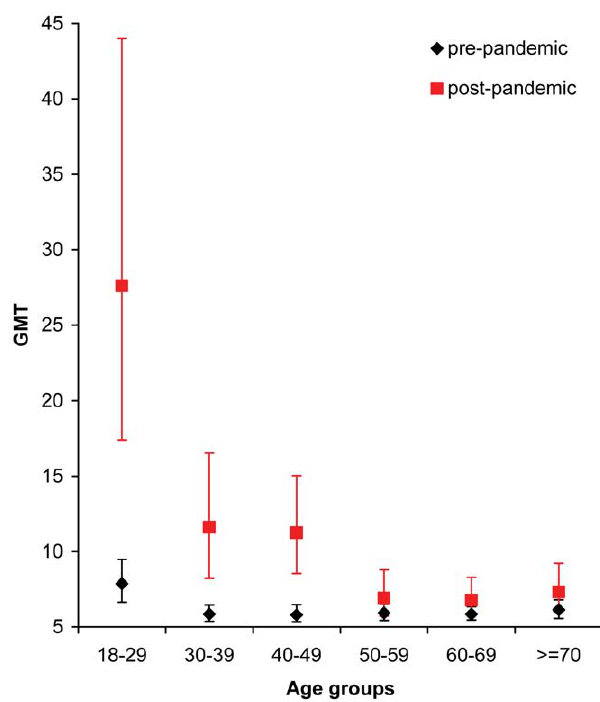
Figure 1. GMT by age group in pre-pandemic and post- pandemic period. In the six age groups in the pre-pandemic sample the GMT ranged from 5.8 to 7.9. GMT in those aged 18 to 29 years (7.9) in comparison to those 30 years of age and older (5.9) was significantly higher. When comparing pre- and post-pandemic results, age groups 18–29, 30–39 and 40–49 had significant increase in GMT with highest increase in the age group 18–29 years.